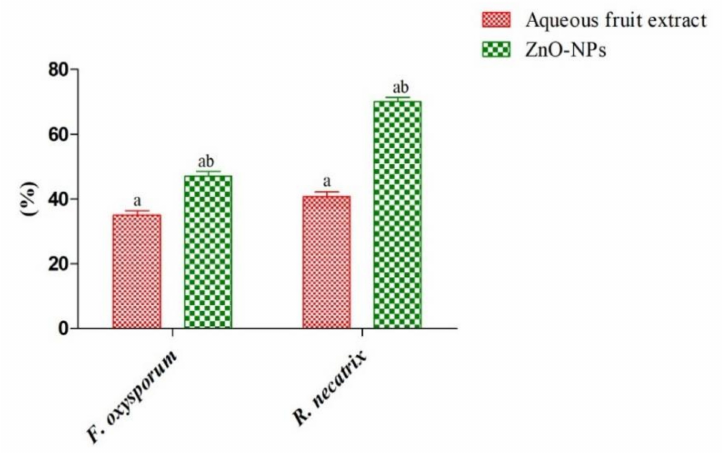
Figure 10. Graphical representation of the antifungal activity of plant extract and ZnO-NPs against plant pathogenic fungi [Different superscript showed significant ( p < 0.05) difference between (a) fruit extract, (b)